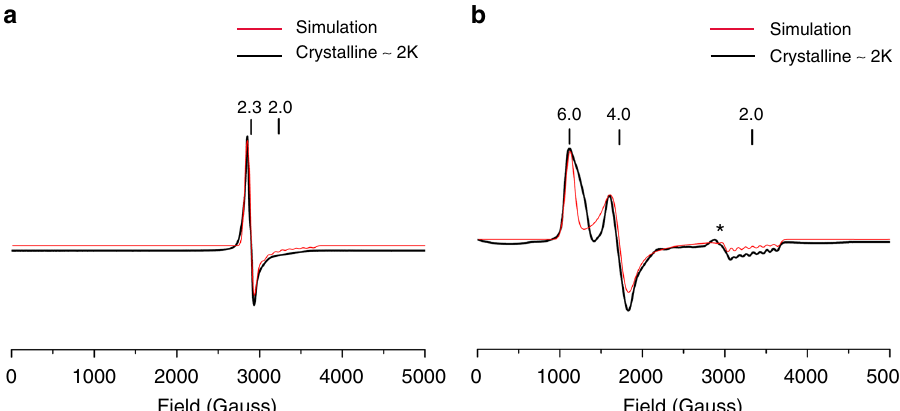
Fig. 2 Experimental and simulated X-band EPR spectra. a [Co(TPP)(2-MeHIm)] and b [Co(TPP)(2-MeIm − )] − . The asterisk represents trace amount of [Co(TPP) ∙∙∙∙ (2-MeIm − )] −